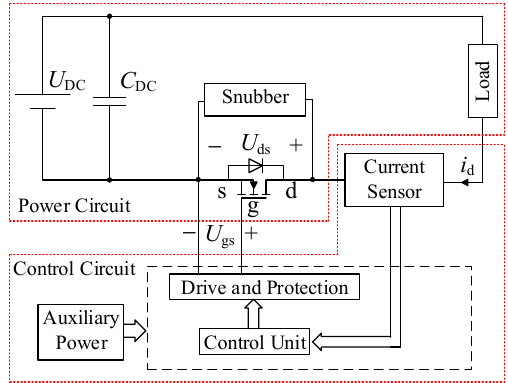
Figure 1. The schematic diagram of solid state circuit breaker(SSCB).